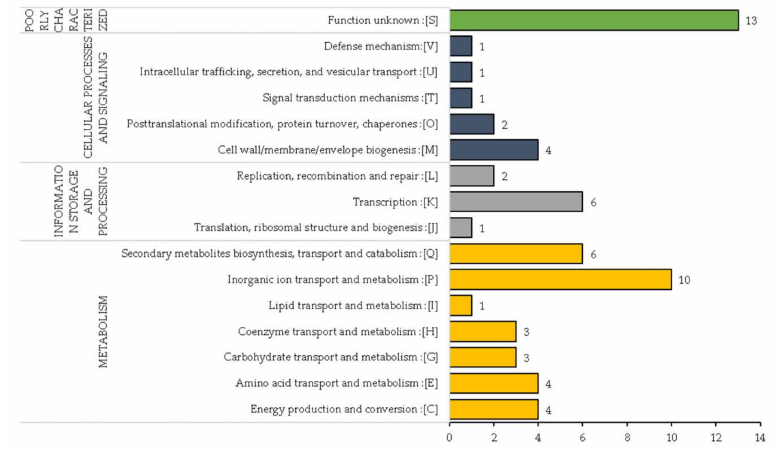
Figure 6. Classification of COG annotations of the genes into 4 general functional categories. The numbers close to the bars indicate the number of genes associated to each COG subcategory.